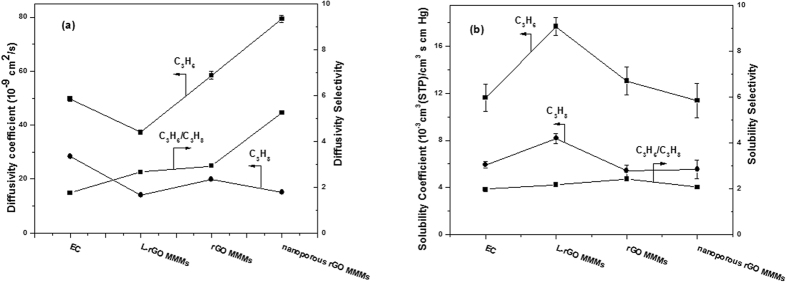
Diffusion coefficient (a) and solubility coefficient (b) of C3H6 and C3H8 in the membranes. (Feed pressure at 0.1 MPa, temperature at 298 K).